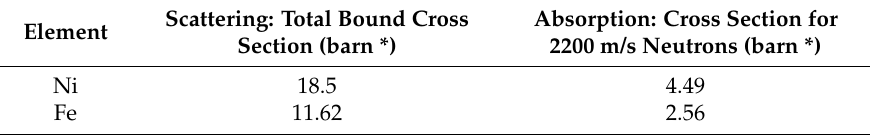
Table 2. Neutron cross sections averaged for the natural isotopes composition for Ni and Fe [25]. Element